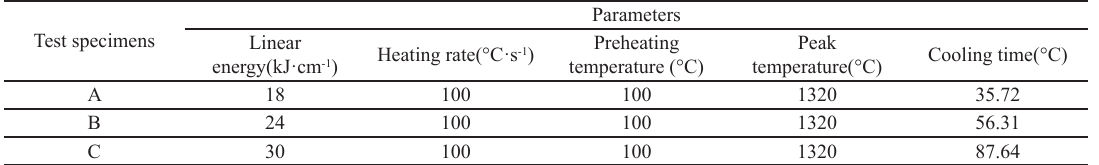
Table 2. The process parameters of welding thermal simulation test. Test